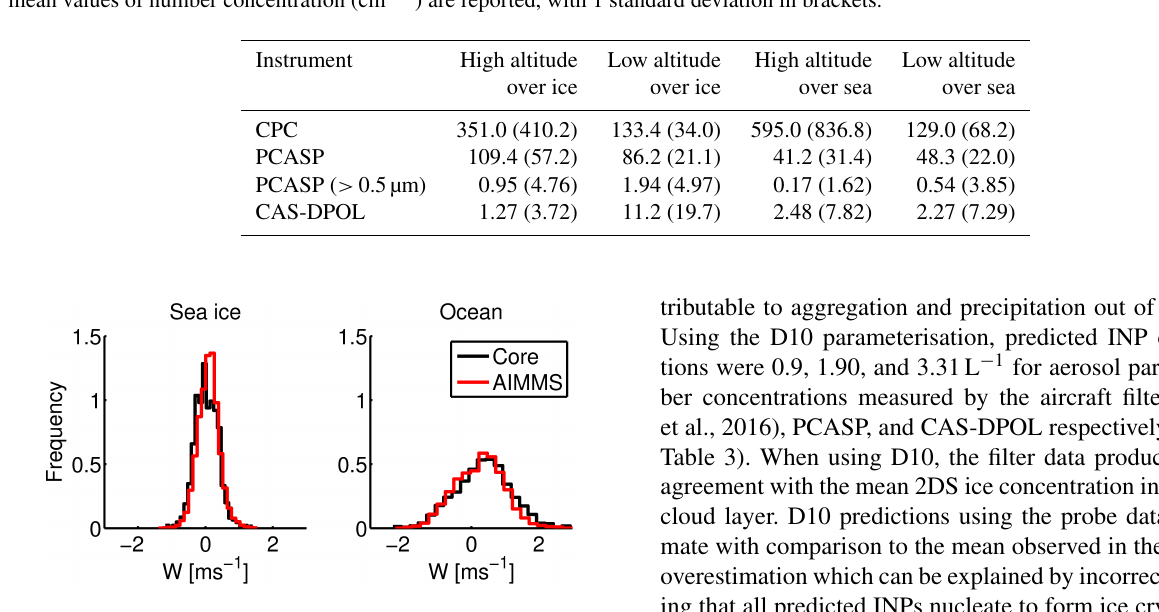
Figure 17. Probability density function (PDF) of updraught velocity from the core turbulence (black) and AIMMS (red) probes. Data from runs 2, 3, and 4 are used for the sea ice, and data from runs 6 and 7 for the ocean. Data from each SLR are normalised such that the mean value is